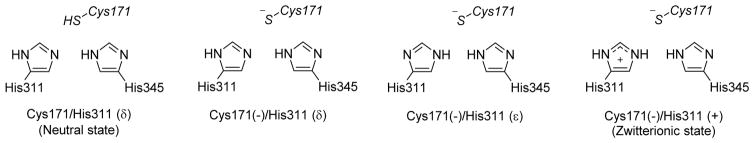
Four possible protonation states of catalytic residues of KasA.